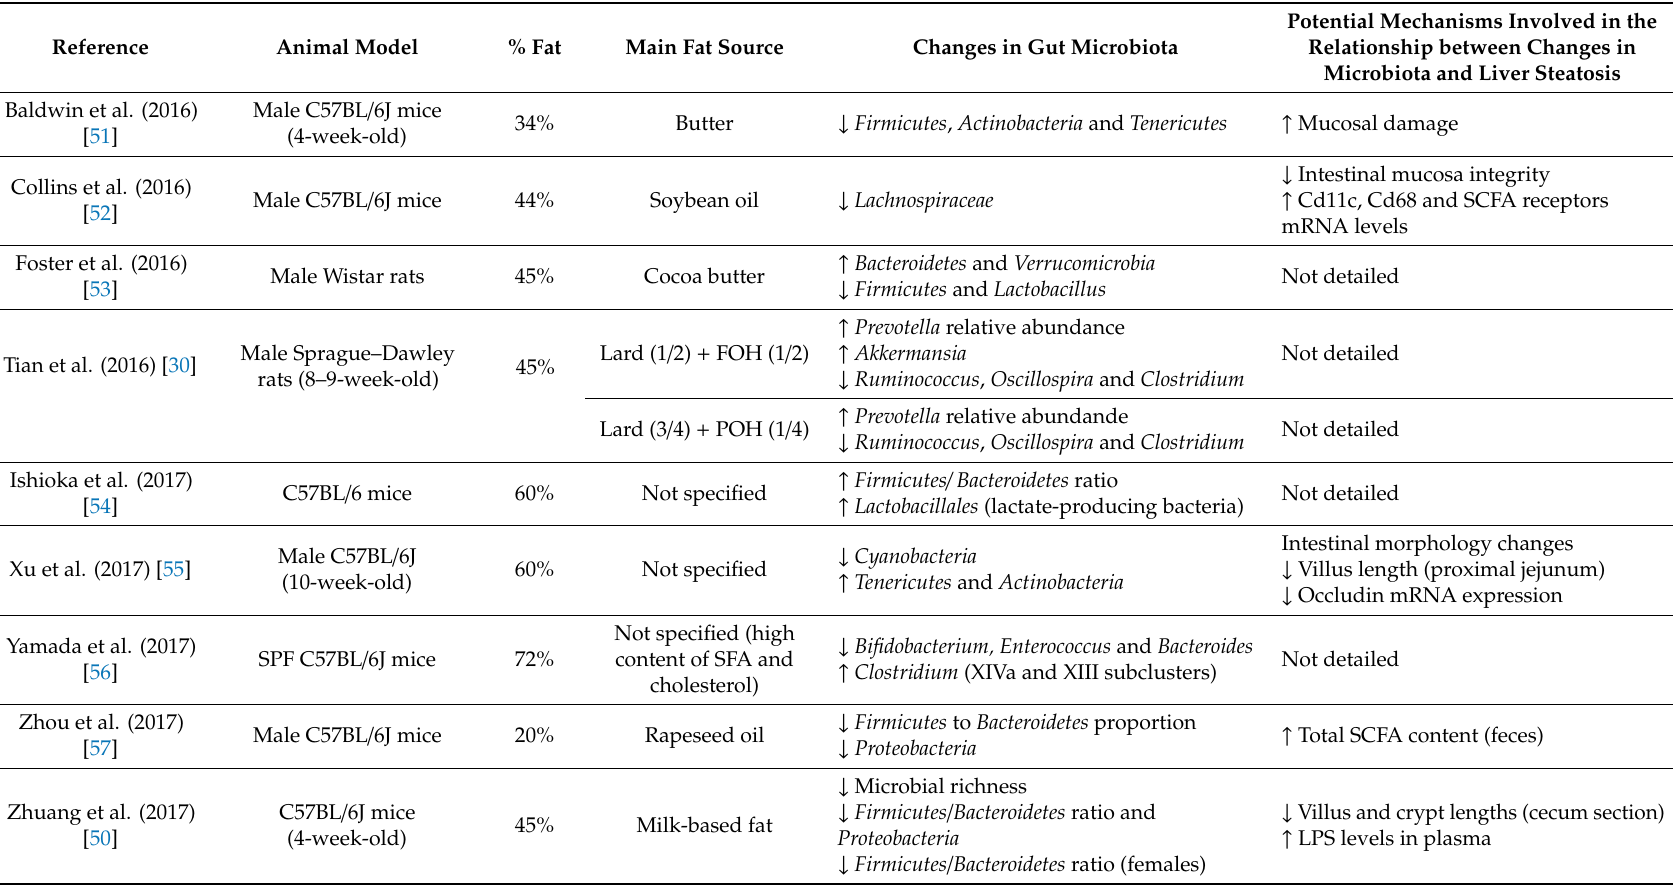
Table 2. Studies conducted in rodent models using high-fat diets with fat of origins other than lard (butter, milk, plant-based, or unknown